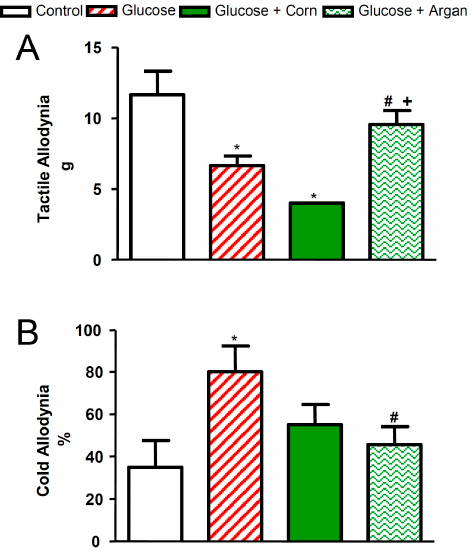
Figure 5. Effects of 12 weeks of glucose feeding combined or not with orally and daily administered (5 mL·kg − 1 ) corn oil or argan oil on ( A ) tactile allodynia expressed in g and ( B ) cold allodynia expressed in %. Values are the mean ± SEM of 4–7 rats per group. * p < 0.05 vs. control, # p < 0.05 vs. glucose, + p < 0.05 vs. glucose + corn oil.